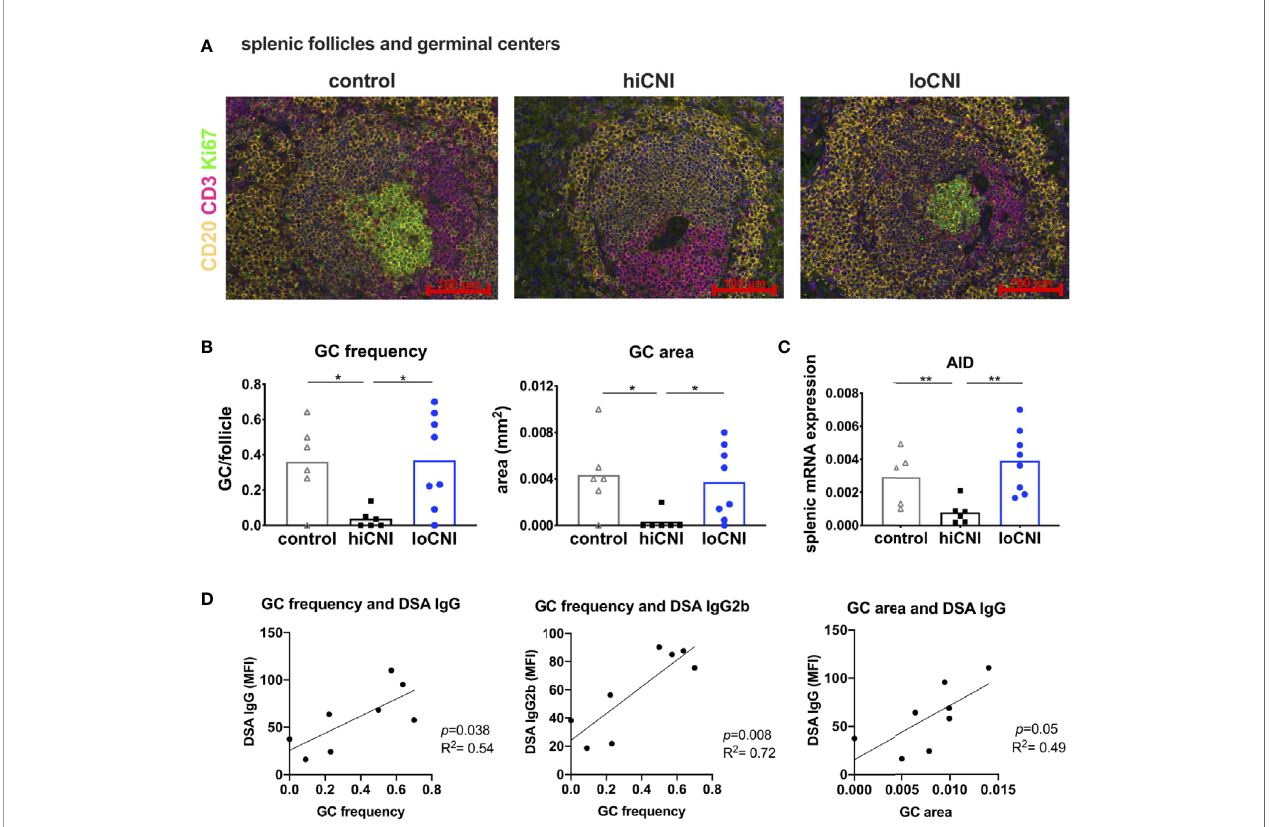
FIGURE 3 | Germinal center formation. (A) immuno fl uorescence staining of splenic follicles with T cell zone (CD3 + , red), B cell follicle (CD20 + , yellow) and GC (Ki67 + , green) and (B) average frequency and area of GC per follicle from controls (n=6), hiCNI (n=6) and loCNI (n=8). (C) splenic AID mRNA expression measured by qPCR in controls (n=5), hiCNI (n=6) and loCNI (n=8), normalized to house-keeping gene HPRT and expressed as delta CT (AU). Means and individual data points are shown; statistical signi fi cance between groups is shown as *p ≤ 0.05 and **p<0.01. (D) Correlation of GC frequency or area with IgG and IgG2b DSA MFI within the loCNI